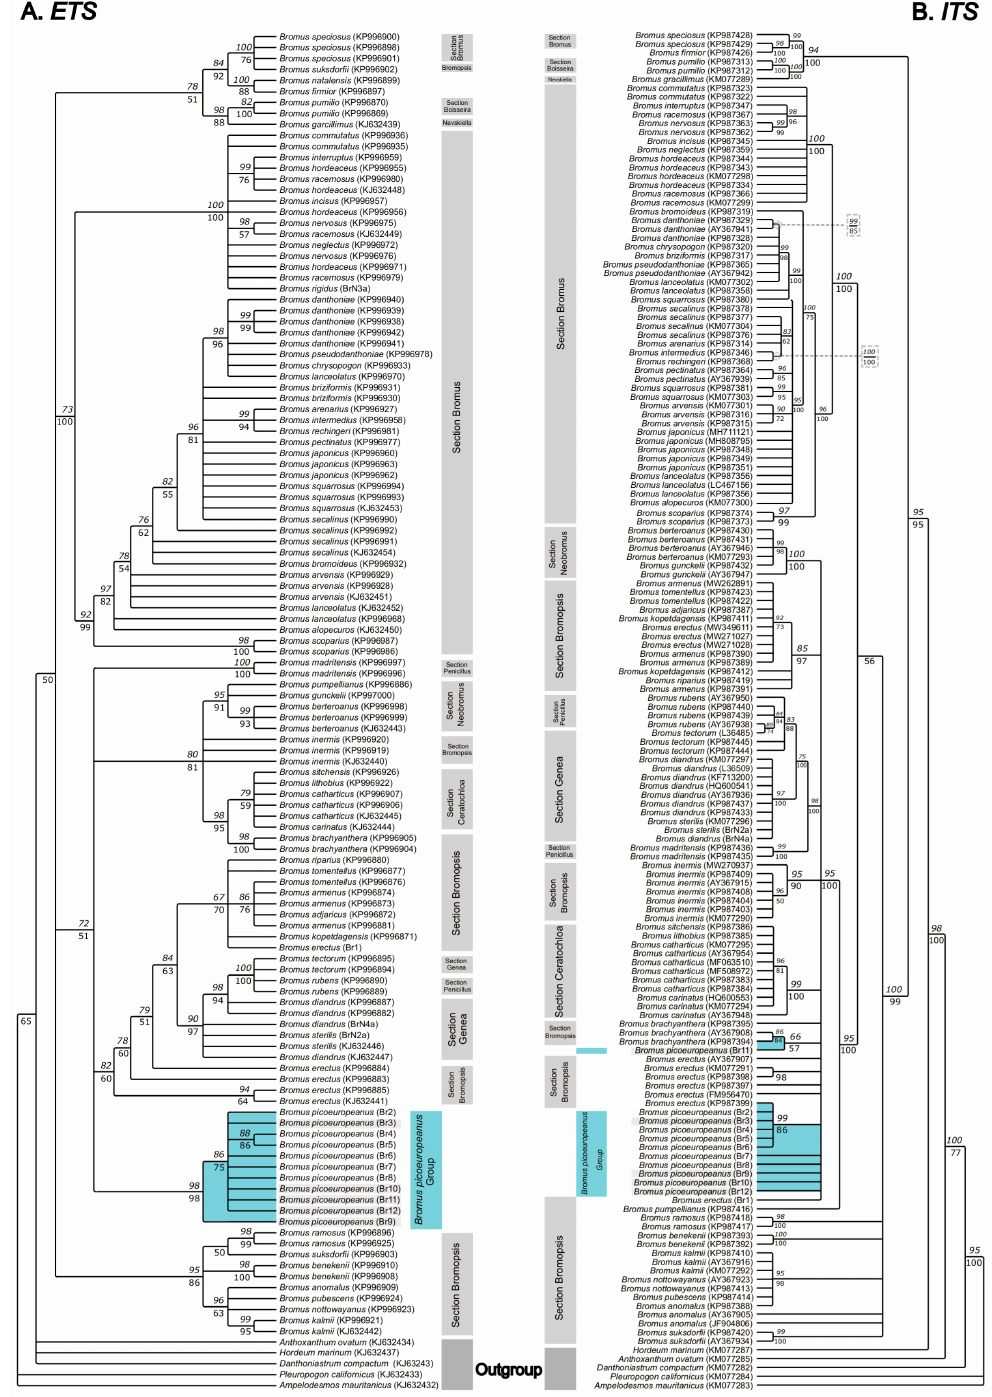
Figure 3. Consensus phylogenetic tree was obtained from ML and BI analyses based on the nuclear marker ETS ( A ) and ITS ( B ). The numbers over the branches correspond to the bootstrap (BS) values from the ML analysis, whereas the numbers under the branches represent the posterior probabilities (PP) obtained during the BI analysis. Br: new Bromus samples were generated in this study. The Br samples from the Cantabrian Mountains and from Picos de Europa have been highlighted in blue. The Br sample from lower lands has been highlighted in gray.